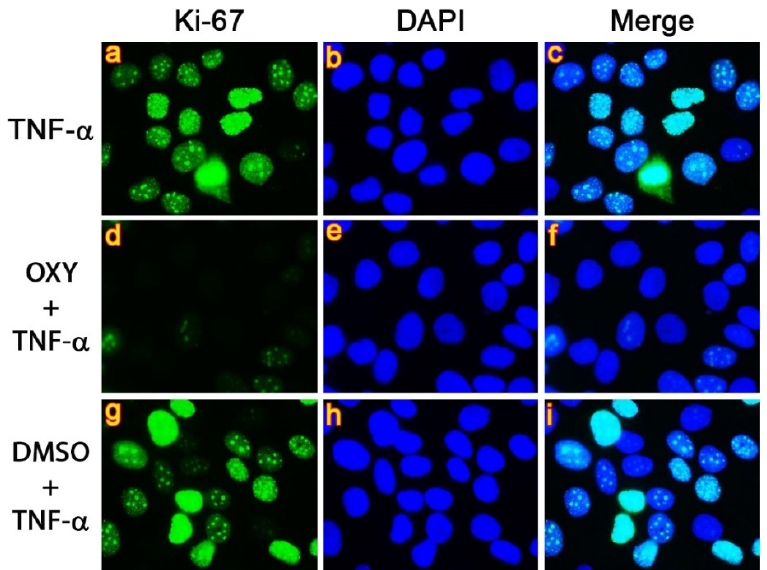
10 of 15 Figure 6. Effects of OXY on TNF- α -induced HaCaT cell proliferation and cycle progress. ( A ) Colony forming assay of HaCaT cells pre-treated with OXY extract at different concentrations (10, 20, and 40 μ M) for 3 h, stimulated with 100 ng/mL of TNF- α for, and observed by a phase-contrast micro- scope (10× magnification) at different time points (0, 24, 48, and 96 h). ( B ) Cell counting assay for TNF- α -stimulated HaCaT cells treated with OXY at different concentrations and at different time points. ( C ) Cell cycle analysis indicating the effects of OXY on cell cycle distribution. * p < 0.05 in comparison to the TNF- α -treated group. 3.5. OXY Inhibits TNF- α -Induced Expression of Proliferation and Survival Markers in HaCaT Cells Since we observed that OXY blocks phosphorylation of AKT and GSK3- ᵦ , which caused cell cycle arrest and significant reduction in number of cells stimulated with TNF-